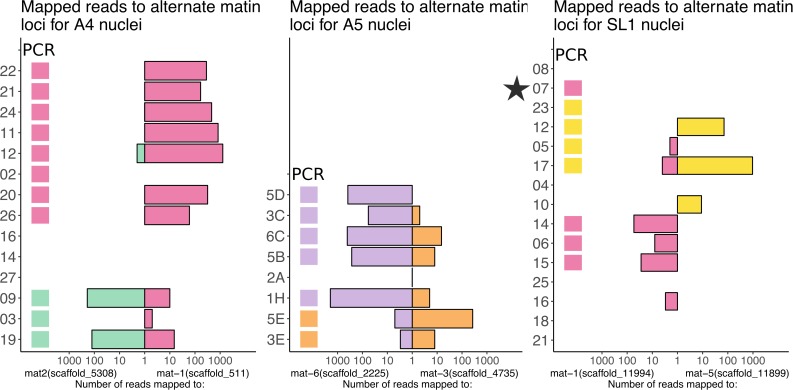
The critical mating type of nucleus 07 (black star) from SL1 is unsupported by short-read data.The two mating type regions for A4, A5, and SL1 were identified in silico with BLAST searches using the primer sequences and methodology of Ropars et al. (2016). Two mating type loci were identified for each of the three isolates. Reads mapping to either of the two alternate mating type loci are shown below on a log scale. Colors are according to Figure 3 of Chen et al. (2018a), and colored boxes near labels indicate mating type based on PCR amplification as reported in Chen et al. (2018a). Figure 4—figure supplement 1—source data 1. contains a list of all the mating loci identified in A4, A5, and SL1 genome assemblies. This figure shows a general congruence between PCR validated mating types and the number of reads that mapped to either of the two alternate mating loci. For isolate A4, for all nuclei with aligned reads, the PCR results matched the majority of the reads (note the log scale), and 02 and 03 were successful for PCR with no short reads mapped. For isolate A5, all nuclei with a PCR amplified mating type also had a majority of reads mapping to one mating type. Nuclei from SL1 had less success with both short read or PCR, likely due to decreased amplification breadth. Critically, nuclei 07 from SL1 (starred) had no short-reads mapped to either mating locus.10.7554/eLife.47301.010Figure 4—figure supplement 1—source data 1.Mating loci identified in A4, A5, and SL1 genome assemblies.Ths file includes the locations of identified loci, and primer sequences used for BLAST searches. These locations were used for aligning reads from Figure 4—figure supplement 1.